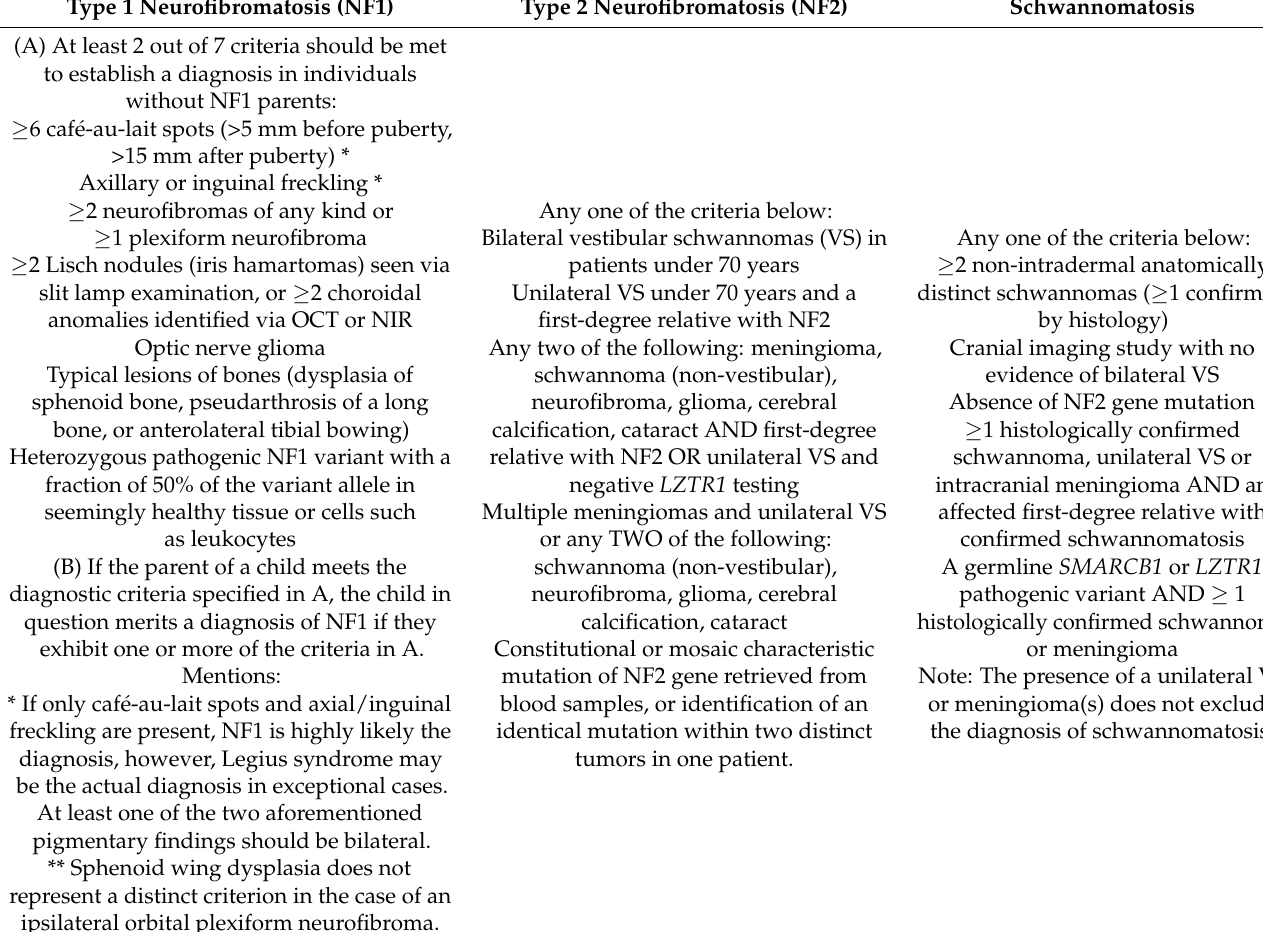
Table 2. Diagnostic criteria for the